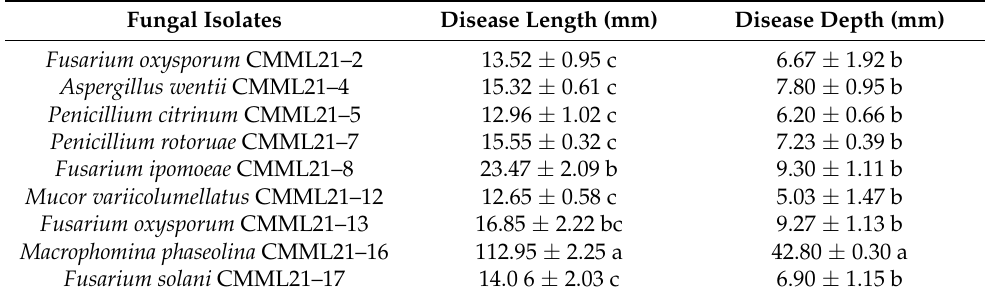
Table 2. The pathogenicity of the pathogenic species obtained in the present study in a sweet potato variety (Beniharuka) 3 weeks after surface wound inoculation.